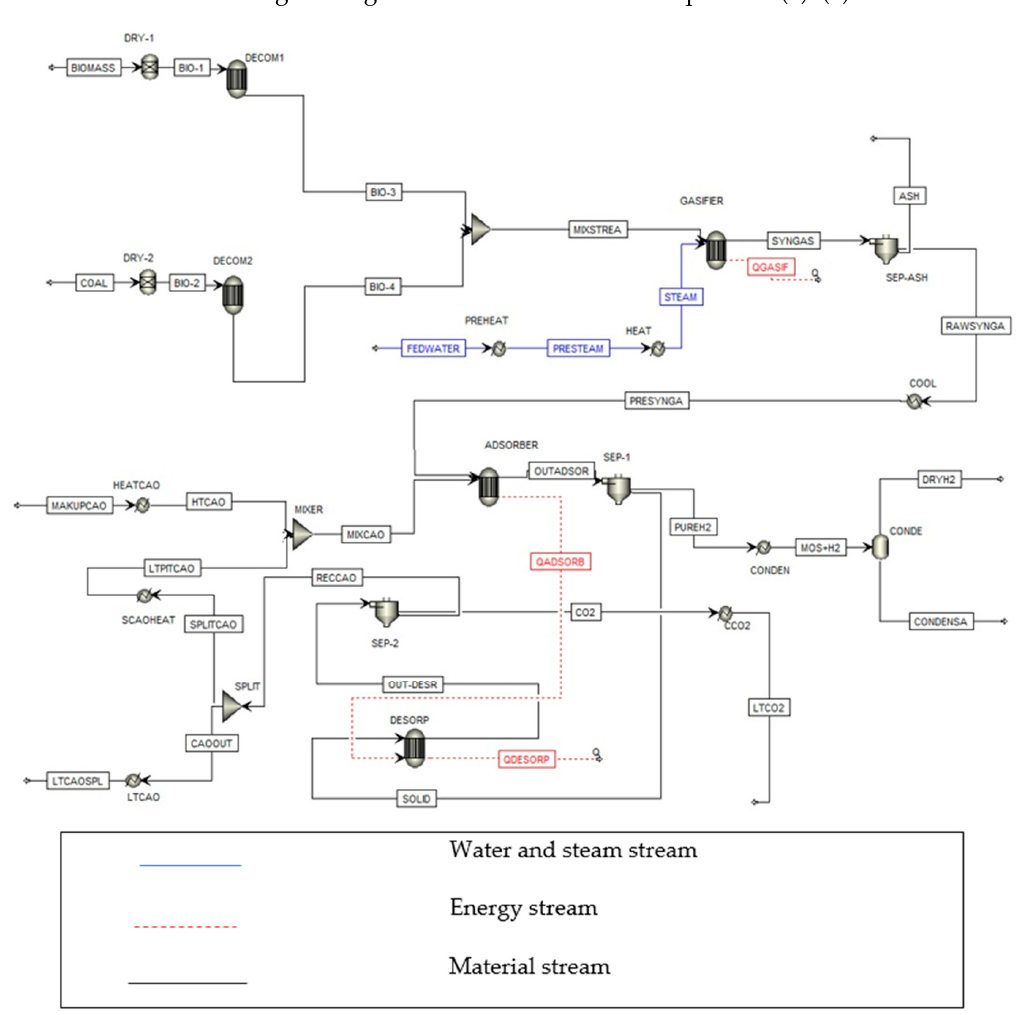
Figure 1. The schematic process flow diagram of the co-gasification of biomass and coal integrated with the calcium looping carbon dioxide capture process. Table 1. Proximate analysis, ultimate analysis (wet basis), lower heating values, and CO 2 emission factors of pellet pine wood, lignite coal, and rice